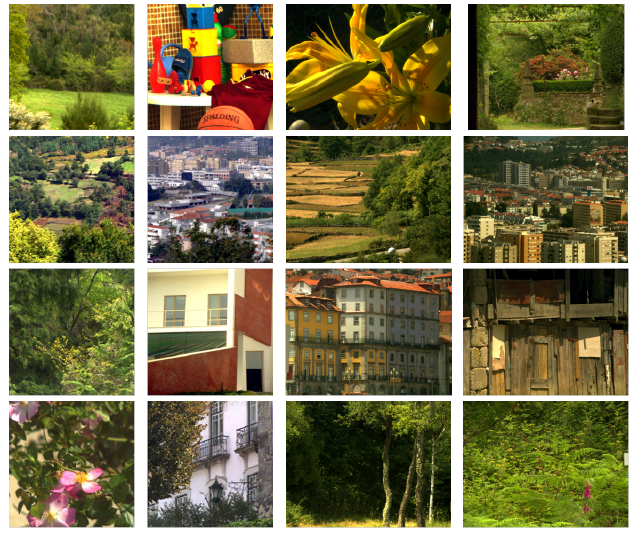
Figure 9. Foster et al. [40] hyperspectral dataset used in Experiments 2 and 3 .